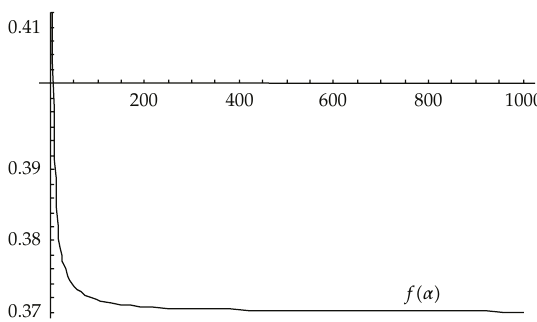
Figure 4: Graph of function f (cid:6) α (cid:7) for α >